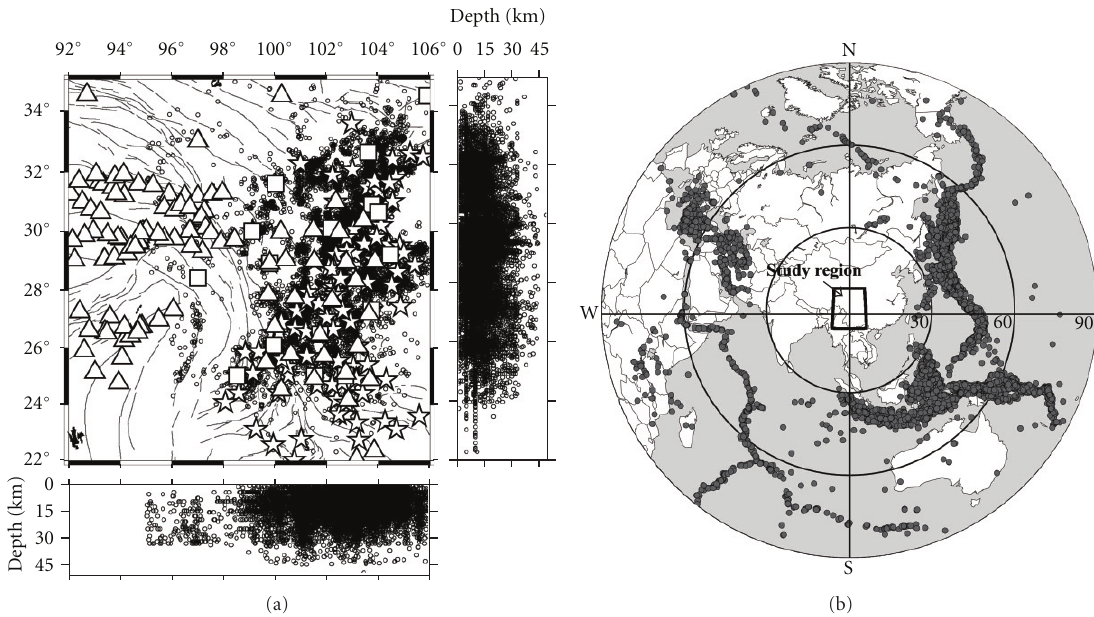
Figure 2: (a) 3D hypocenter distribution of local earthquakes. Black circles show the hypocenters of 14,474 local earthquakes with magnitude larger than 1.5. Open stars show the permanent stations deployed by the Seismological Bureaus of Sichuan and Yunnan Provinces. Open squares show the seismic station by the Institute of Geophysics of China Earthquake administration and the International Seismological Center (ISC). Triangles indicate the temporal seismic arrays (see Tables 1 and 2). (b) Epicenter distribution of the 4782 teleseismic events (gray dots) used in this study. The concentric circles correspond to epicentral distance of 30 ◦ , 60 ◦ , and 90 ◦ . The black box denotes the present study